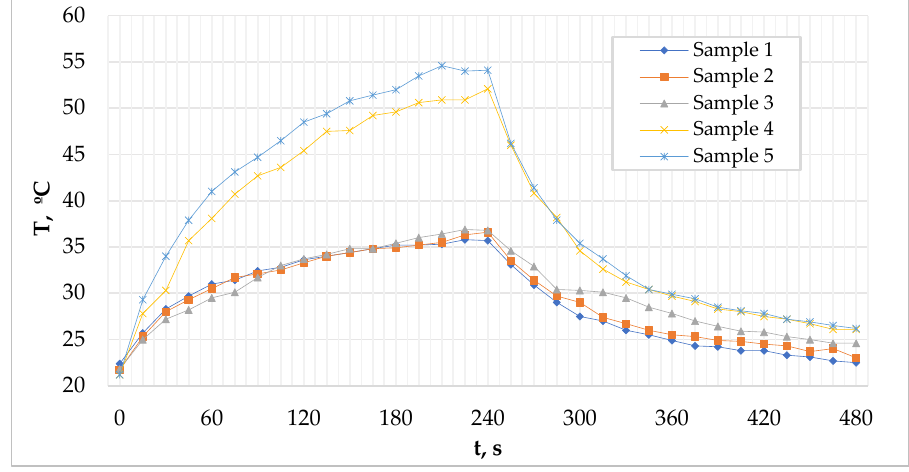
Figure 8. Comparison of dynamic thermal behaviour of the fabric samples containing unmodified and shell-modified PCM microcapsules during the temperature changes.